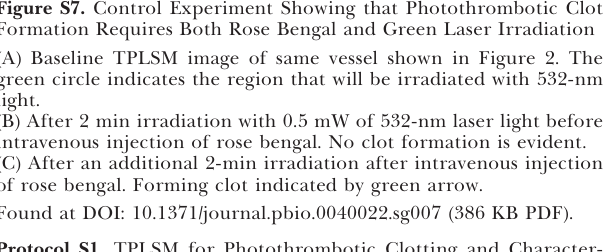
Figure S7. Control Experiment Showing that Photothrombotic Clot Formation Requires Both Rose Bengal and Green Laser Irradiation (A) Baseline TPLSM image of same vessel shown in Figure 2. The green circle indicates the region that will be irradiated with 532-nm light. (B) After 2 min irradiation with 0.5 mW of 532-nm laser light before intravenous injection of rose bengal. No clot formation is evident. (C) After an additional 2-min irradiation after intravenous injection of rose bengal. Forming clot indicated by green